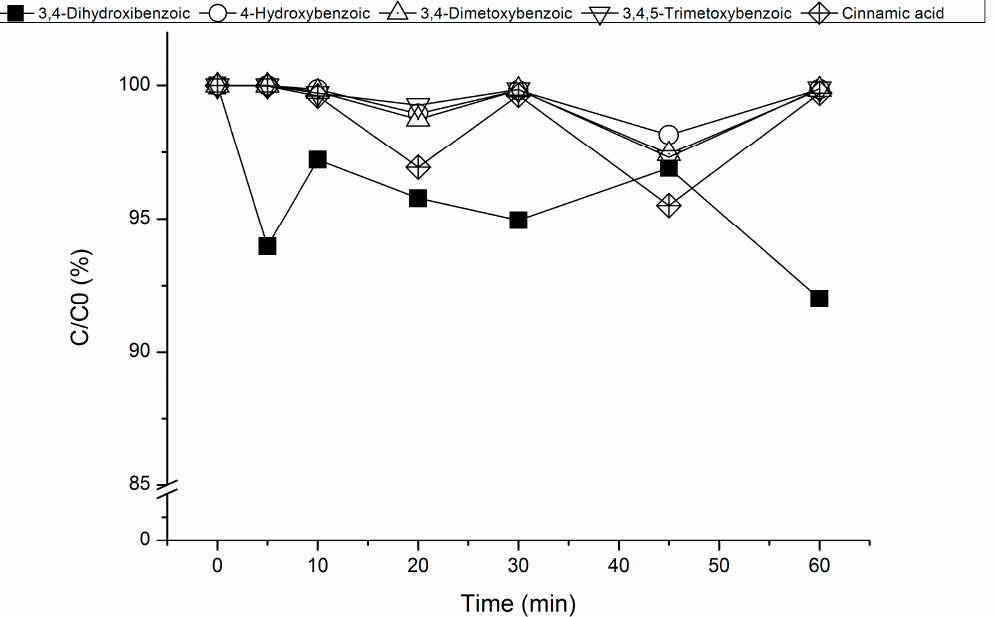
Figure 2. Study of the adsorption capacity of red mud (RM) (pH = 3.4; RM = 1 g/L).